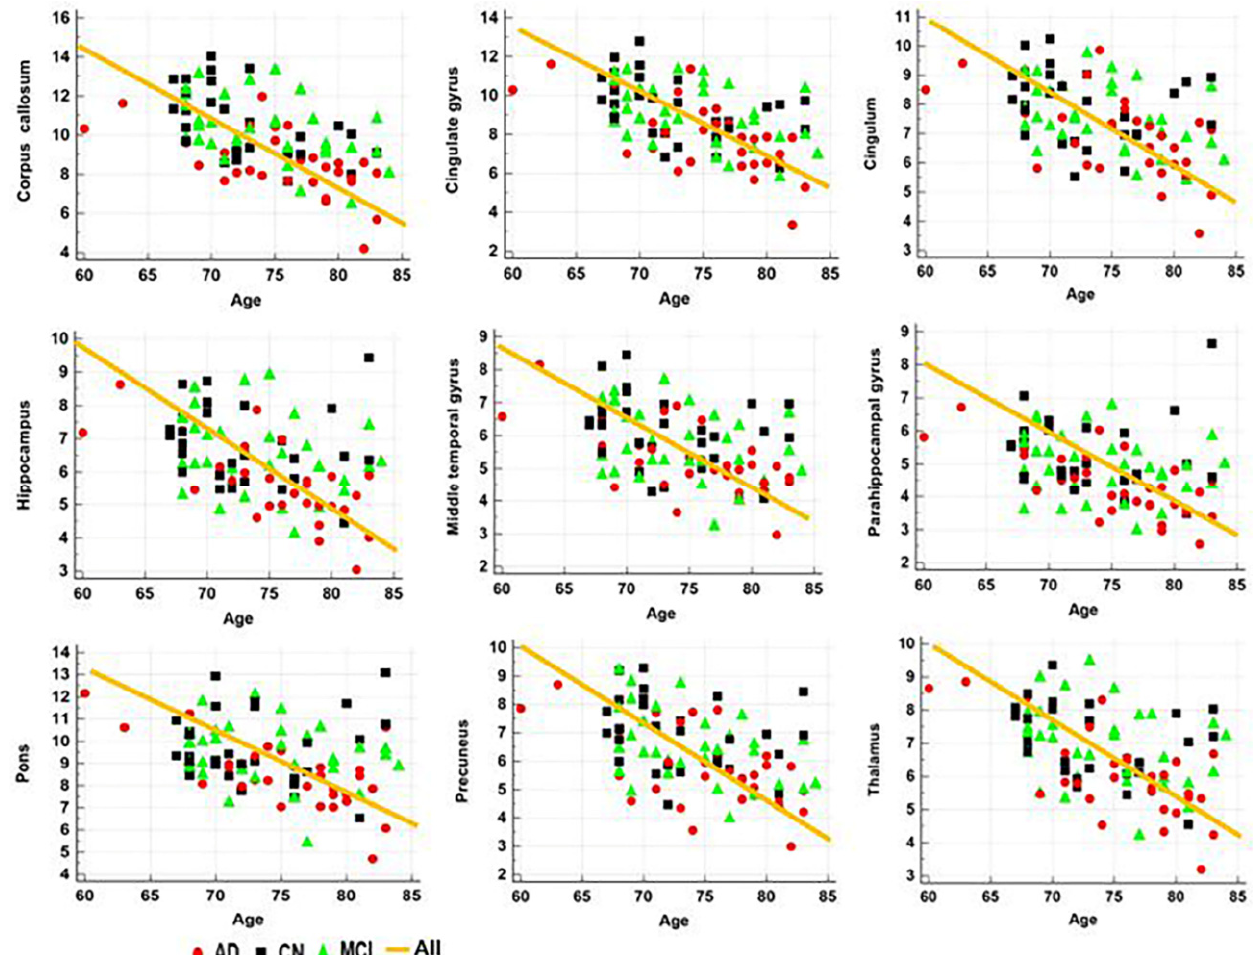
Figure 4. Results of the correlation analysis between the apparent MWF values in the specific brain areas and age.